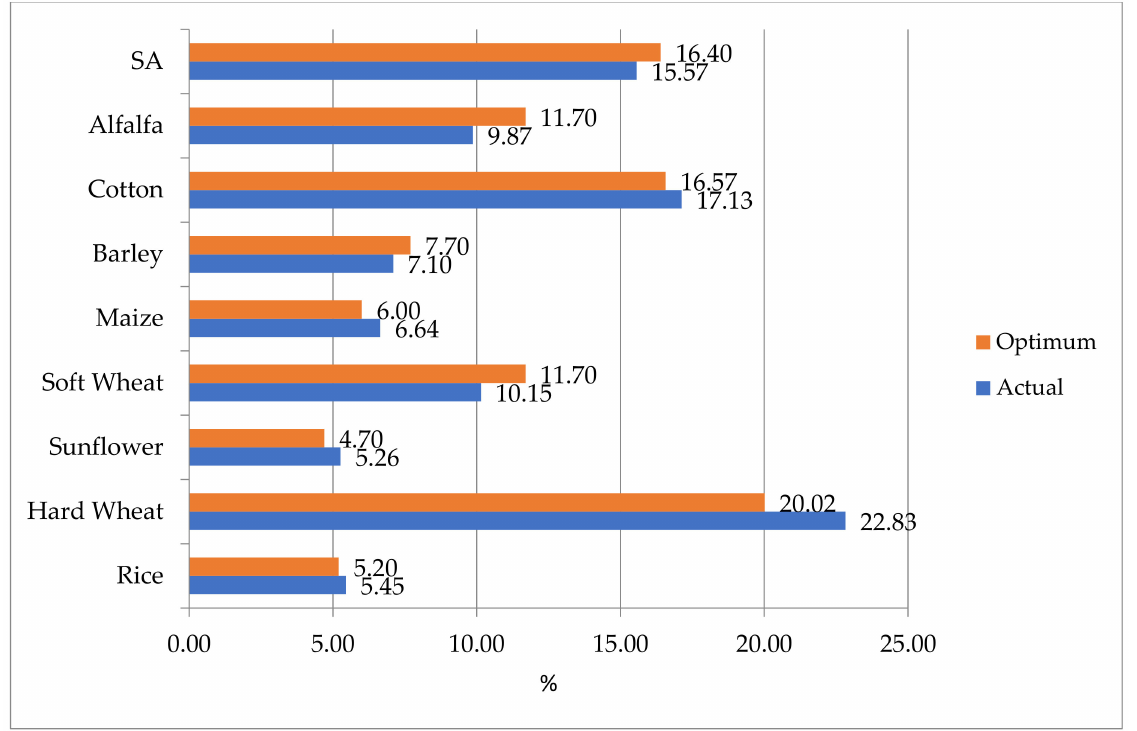
Figure 3. Actual crop plan vs. optimum crop plan